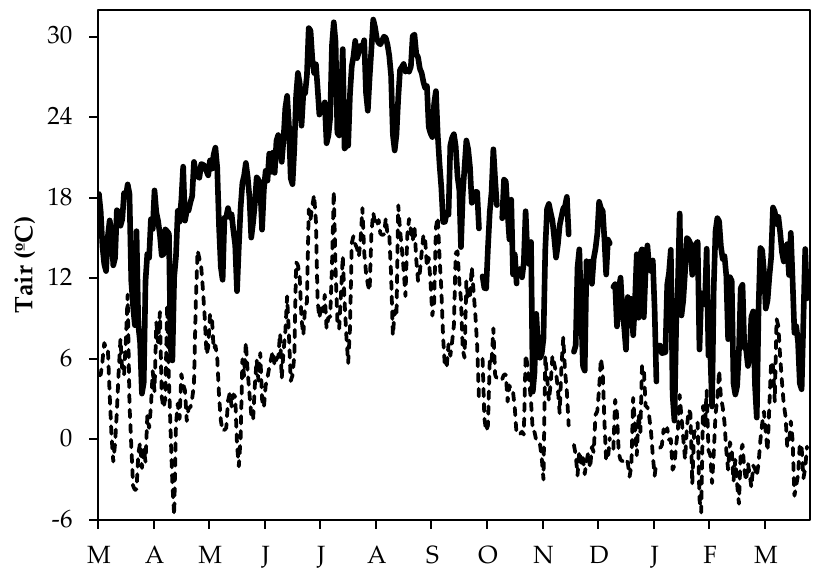
Figure 1. Seasonal course of daily maximum air temperature (solid line) and daily minimum air temperature (dotted line) during the study period.